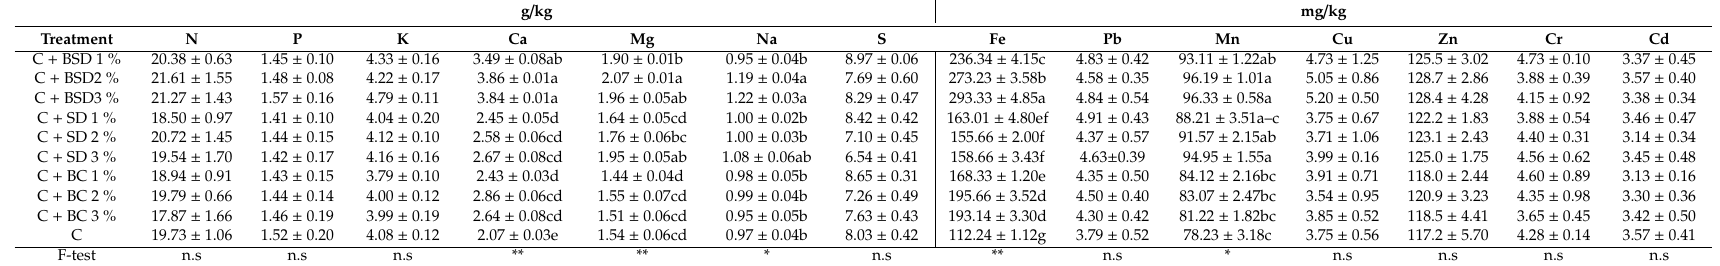
Table 5. Foliar nutrient content in maize plants grown in di ff erent soil amendments ± standard error. g / kg mg / kg